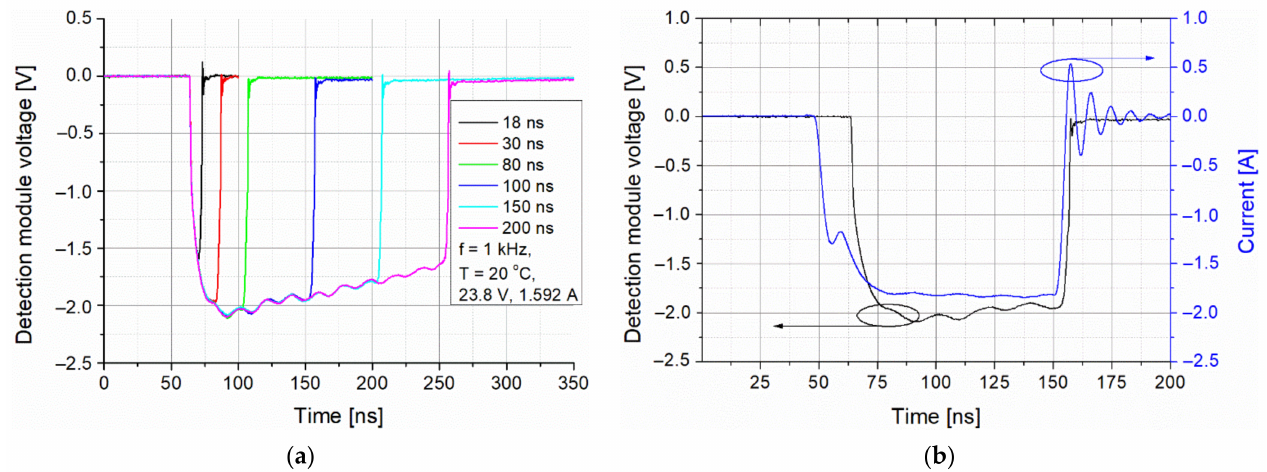
Figure 8. ( a ) Optical signals registered by the detection module for different pulse times and ( b ) shapes of driving current and light signals.